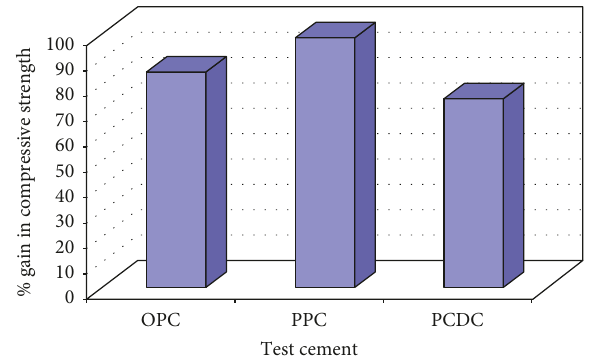
Figure 28: Percent gain in compressive strength versus test cement in sea